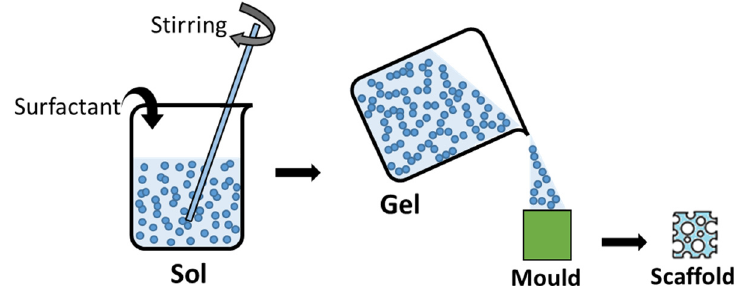
Figure 3. Generation of scaffolds for tissue engineering applications from the sol-gel synthesis process.